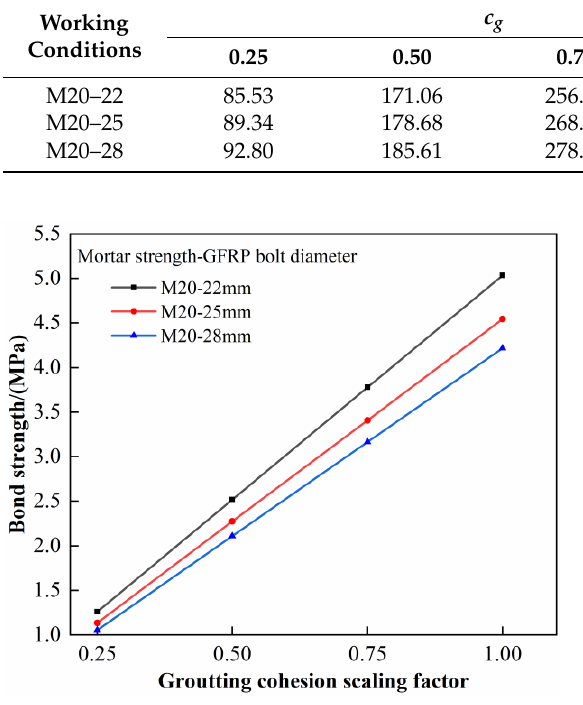
Figure 9. Relationship between computed ultimate bond strength and grout cohesion.